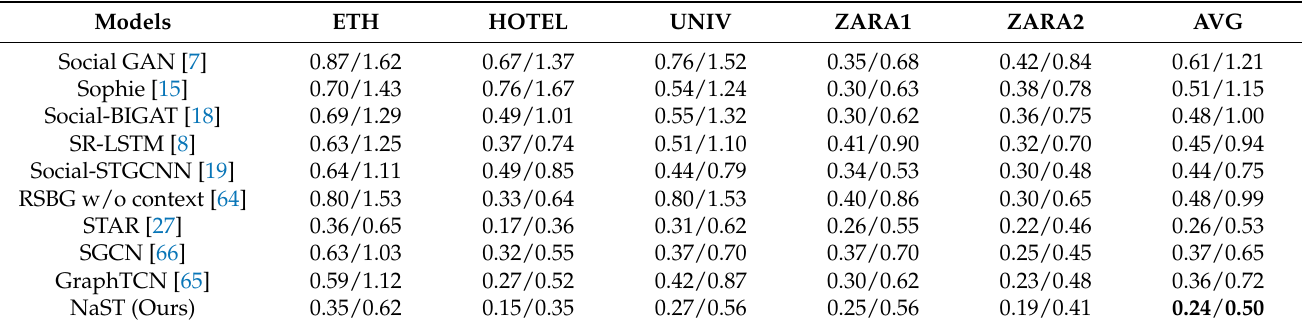
Table 1. Comparison with some models on datasets ETH and UCY of ADE/FDE metrics (the lower numerical result is